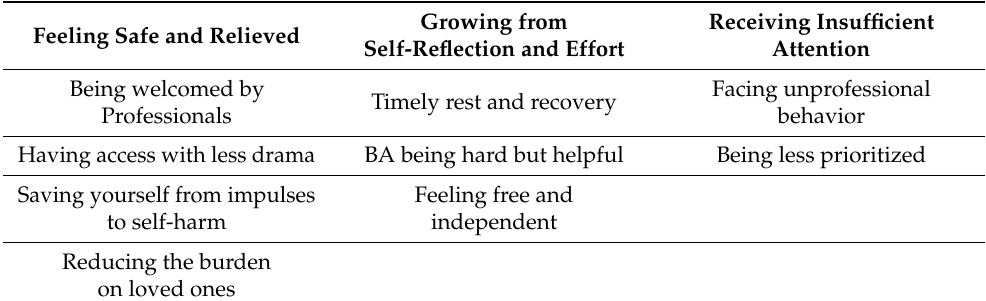
Table 2. Themes and subthemes illuminating adolescents’ experiences of having access to